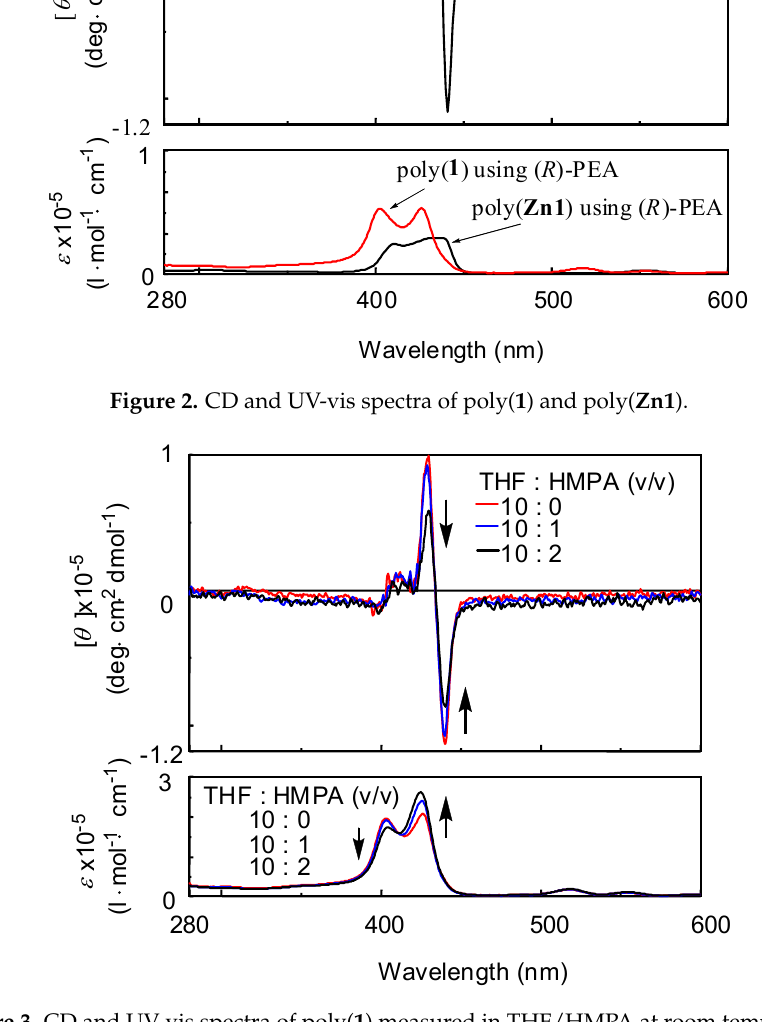
Figure 4. Fluorecence spectra of ( a ) 1 and poly( 1 ), excited at 420 nm; ( b ) Zn1 and poly( Zn1 ), excited at 425 nm ( Zn1 ), excited at 430 nm (poly( Zn1 )); in THF at 20 o C, cell length = 10 mm, c = 0.5 × 10 −6 M based on porphyrin unit).